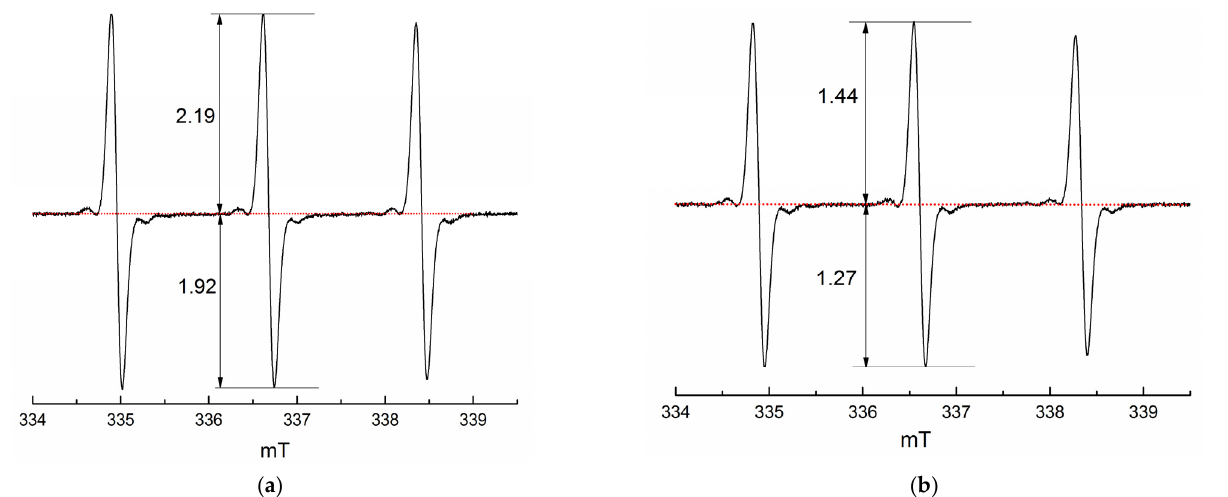
Figure A6. Change of double integral of EPR spectra of TEMPO in PNIPAM aqueous solution in the presence of Cu(II) vs. temperature.